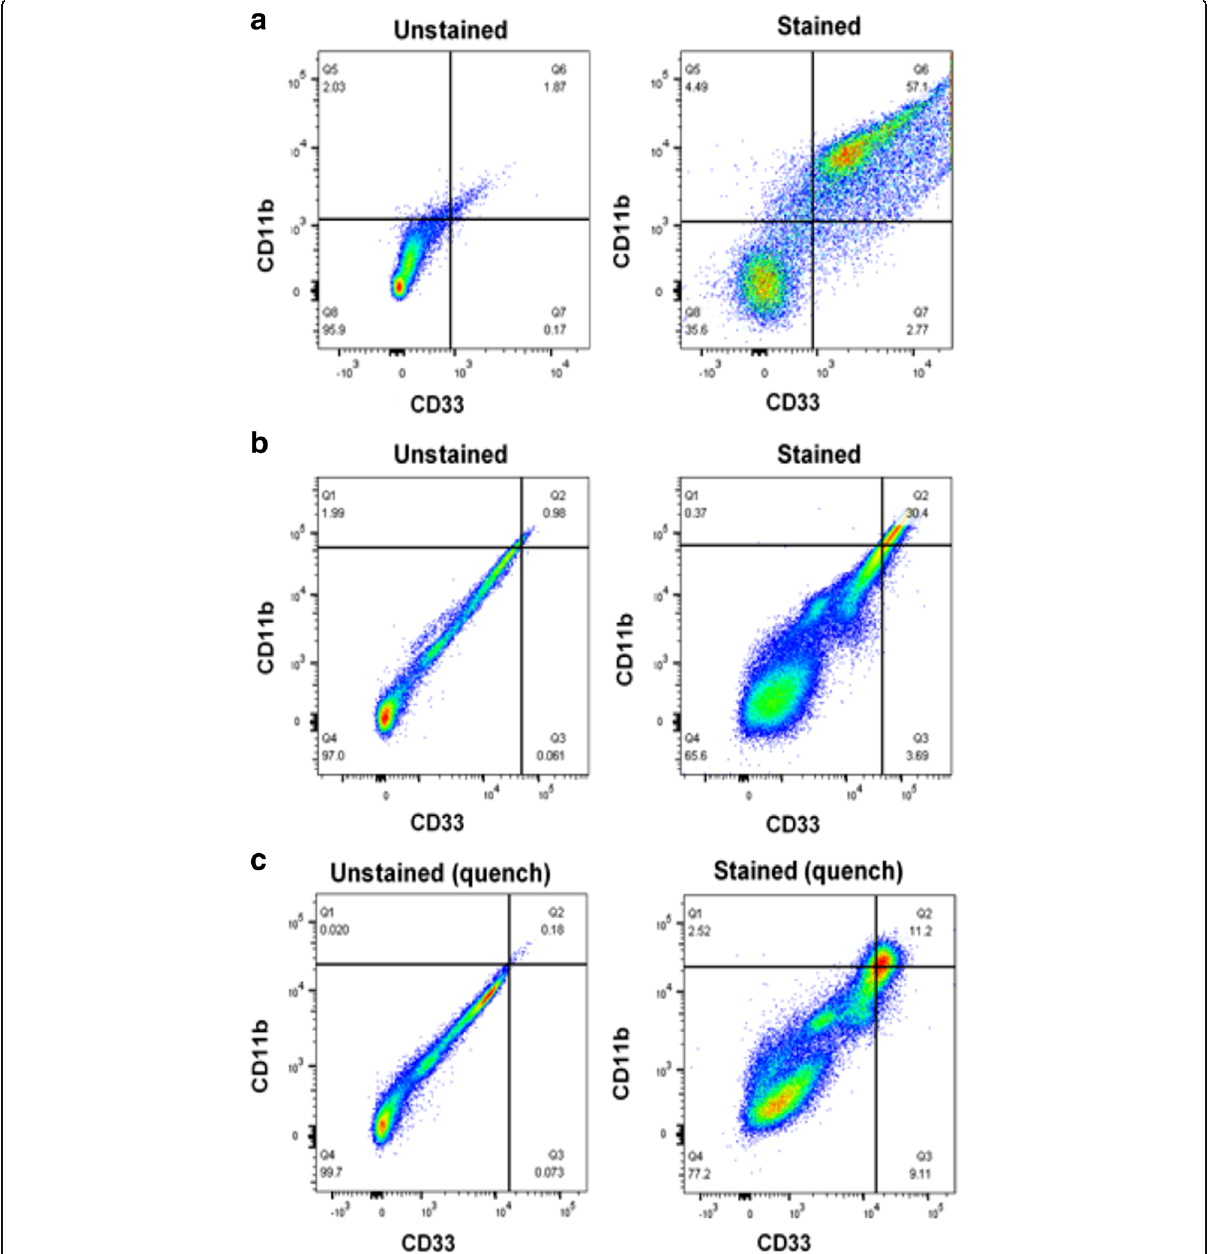
Fig. 6 Identification of myeloid cells from BALC samples of TB patients. FSC and SSC characteristics were selected to define all BALC. All subsequent analyses were performed on cells selected in the BALC gate. a Gating strategy used to define CD11b + CD33+ innate cells from BALC with low autofluorescence signal. b Gating strategy selected to define CD11b+ CD33+ innate cells from BALC presenting with extensive autofluorescence. c Gating strategy identifying CD11b + CD33+ innate cells from the same BALC indicated in ( b ), post quenching